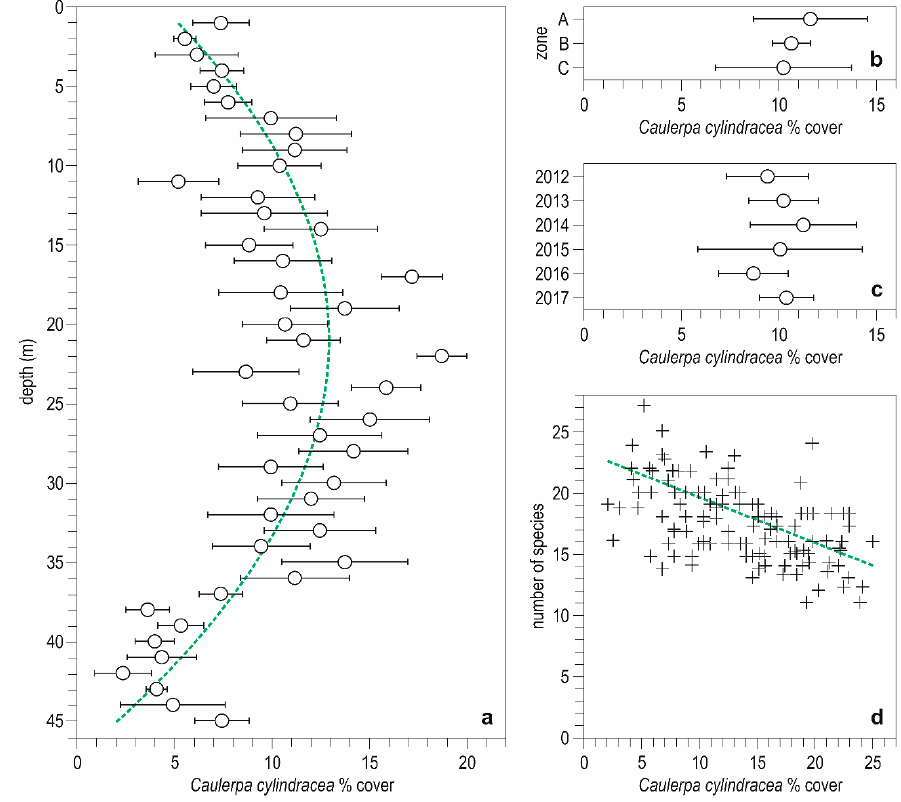
Figure 4. Occurrence of Caulerpa cylindracea in the marine protected area of Portofino (from the comprehensive database of 78 species × 229 samples): ( a ) Depth distribution of the species cover (circles identify the mean depth, error bars are standard errors) between 1 m and 45 m; the binomial curve (dashed line) represents the best fit of mean data (cover = 0.0196 · depth 2 + 0.8313 · depth + 4.1168, R 2 = 0.5003, n = 229, p < 0.01); ( b ) mean ( ± standard error) cover in the three protection zones (A = “no-entry no-take” area, B = general reserve, C = partial reserve); ( c ) change in yearly mean ( ± standard error) cover in the Portofino MPA between 2012 and 2017; ( d ) linear regression (dashed line) between C. cylindracea cover and species richness (number of species = − 0.3653 · cover + 23.111, R 2 = 0.3309, n = 229, p <